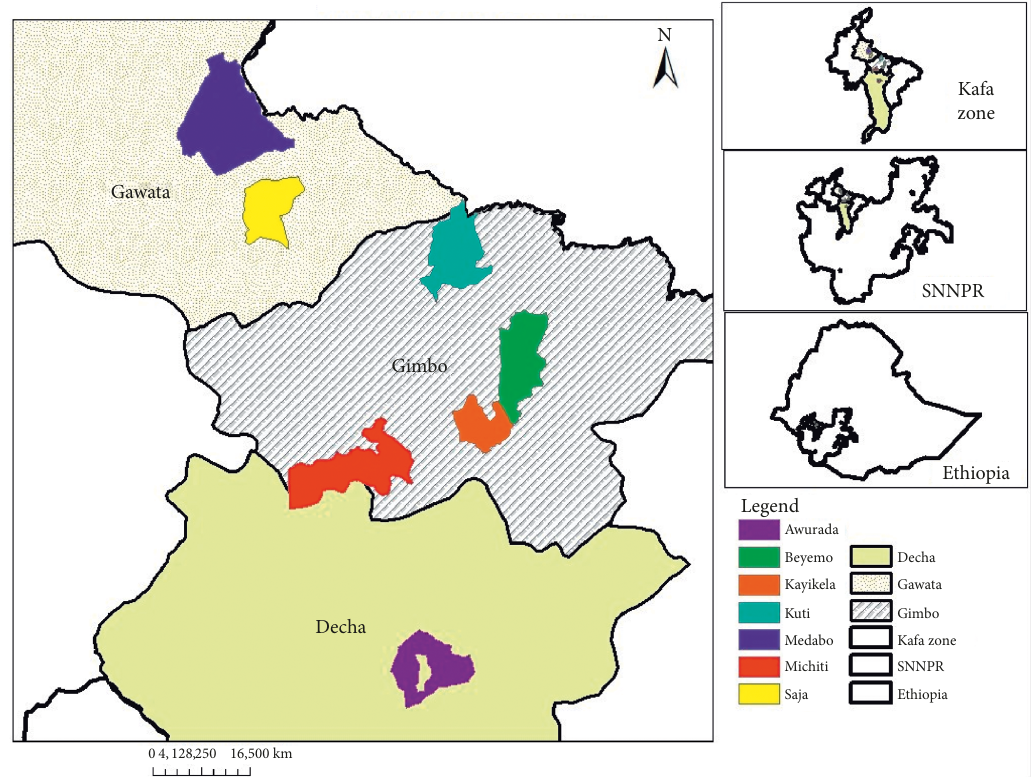
Figure 1: Map of districts and distribution of sampling areas covered in the